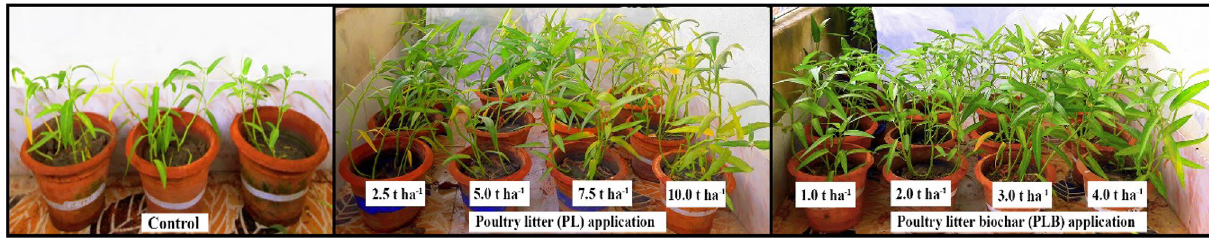
Fig. 2 Visual observation of gima kalmi as second crop grown in previously PL- and PLB-treated